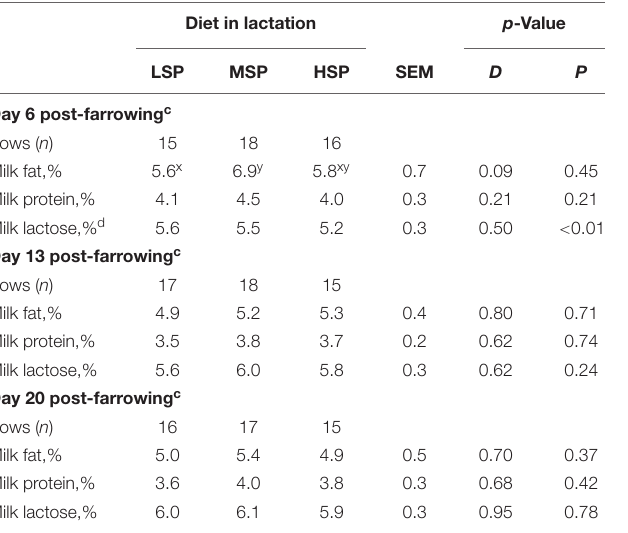
TABLE 6 | Sow plasma IGF-1 (ng/mL), urea (mmol/L), CREA ( µ mol/L), and NEFAs TABLE 5 | Sow milk fat, protein, and lactose concentrations on Days 6, 13, and (mmol/L) concentrations on Days 6, 13, and 20 post-farrowing (LSmeans ± SEM). 20 post-farrowing (LSmeans ± SEM). Diet in lactation p -Value Diets in lactation p -Value